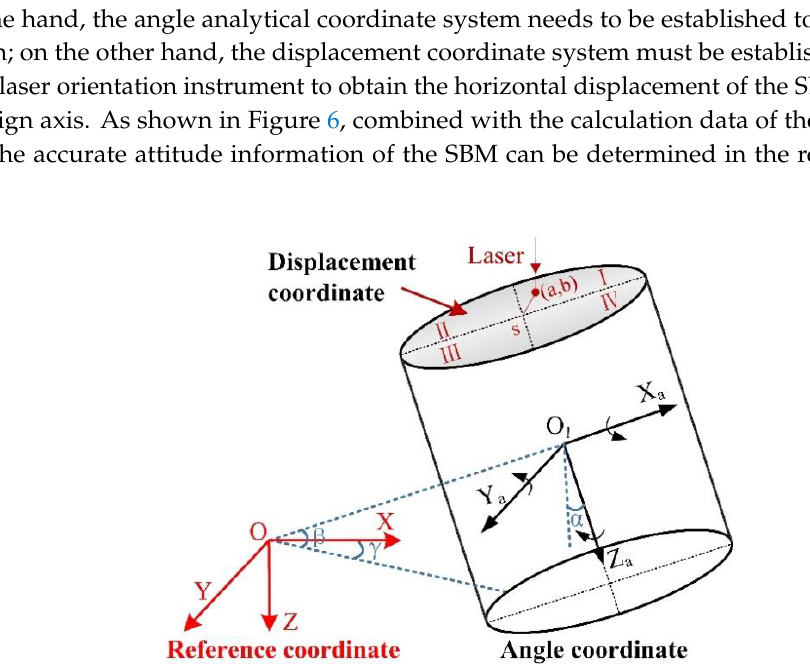
Figure 6. Dual coordinate system of the SBM (angle and displacement).